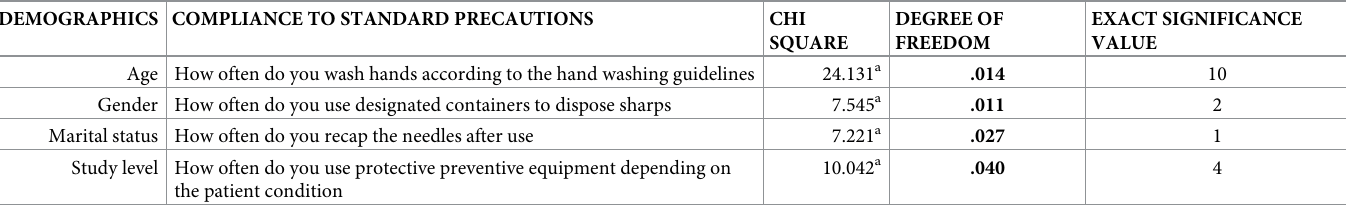
Table 3. Association between demographics and compliance to standard